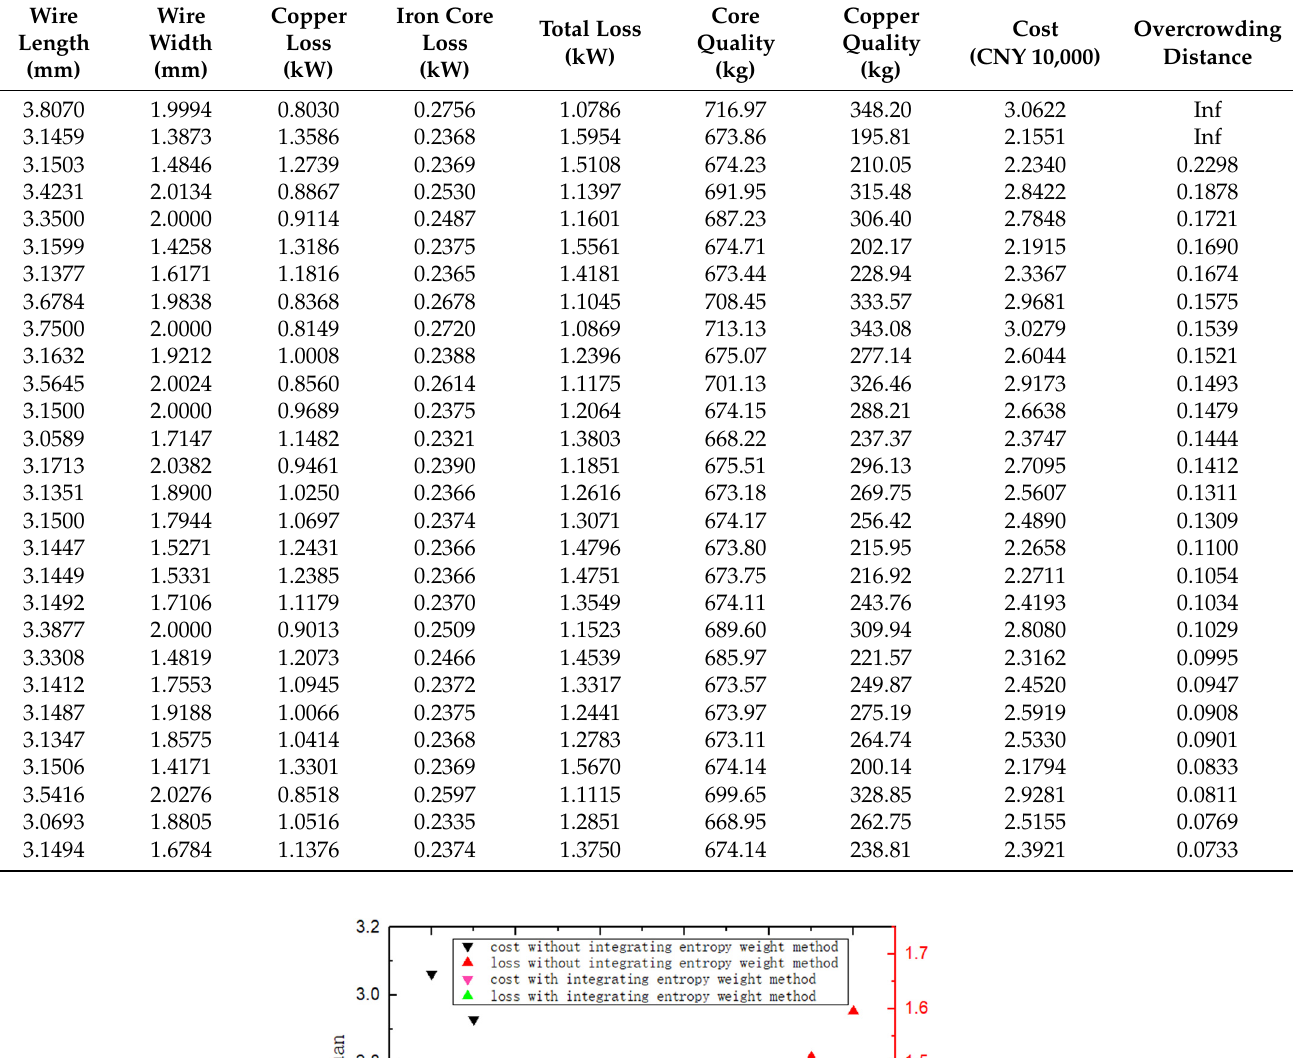
Table 3. NSGA-II algorithm combined with finite element model simulation results.